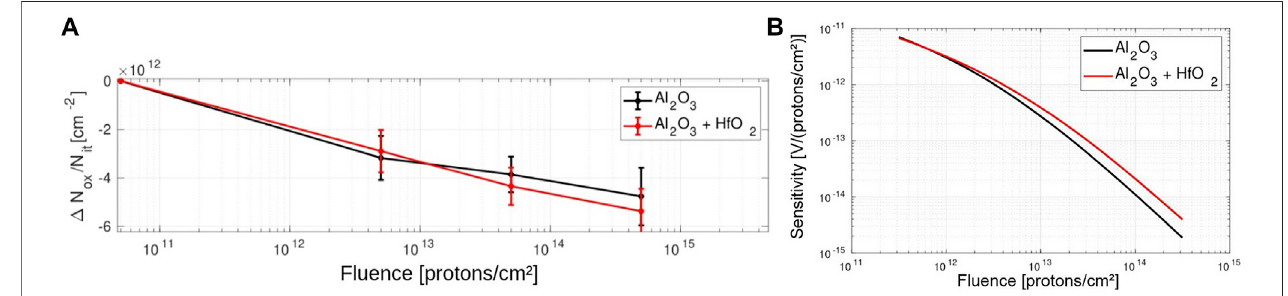
FIGURE 7 | (A) Variation in the cumulative concentration of oxide and interface-trapped charges and (B) sensitivity with fl uence for proton-irradiated MOSFET samples with Al 2 O 3 and Al 2 O 3 + HfO 2 in the oxide